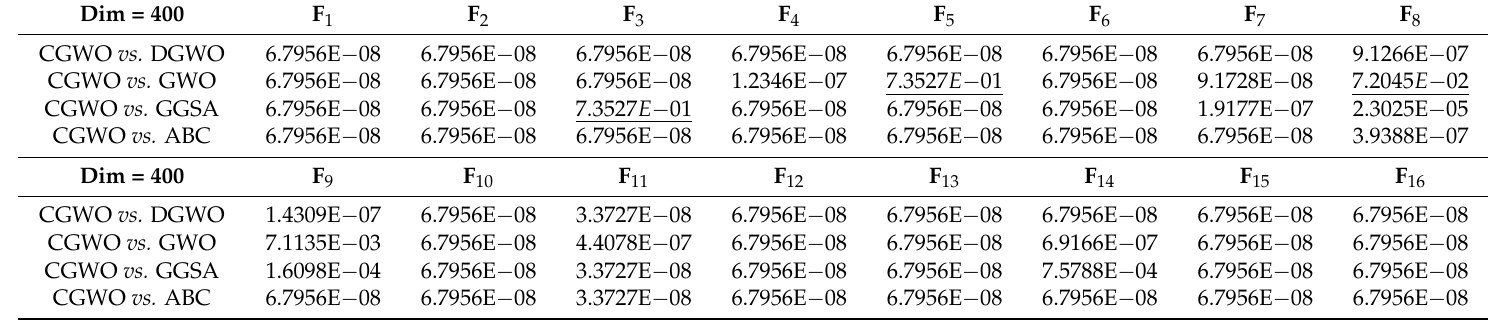
Table 12. p -values produced by Wilcoxon rank-sum test comparing CGWO vs. DGWO, GWO, GGSA, and ABC at Dim = 400 ( p ě 0.05 have been